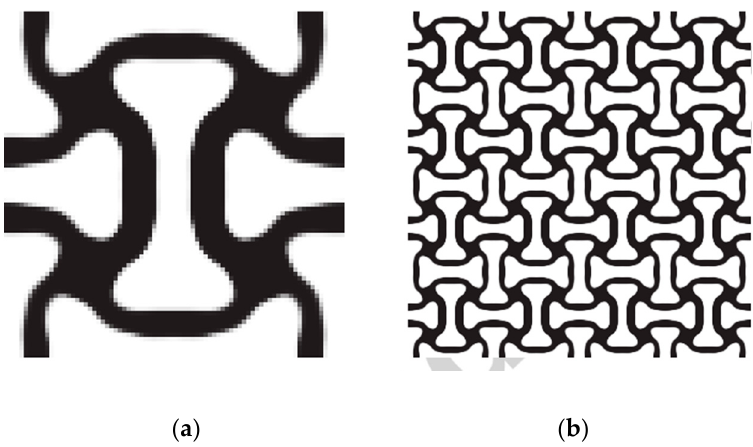
Figure 17. Topology optimization of uniform lattice structure [183]: ( a ) unit cell; ( b ) lattice structure.